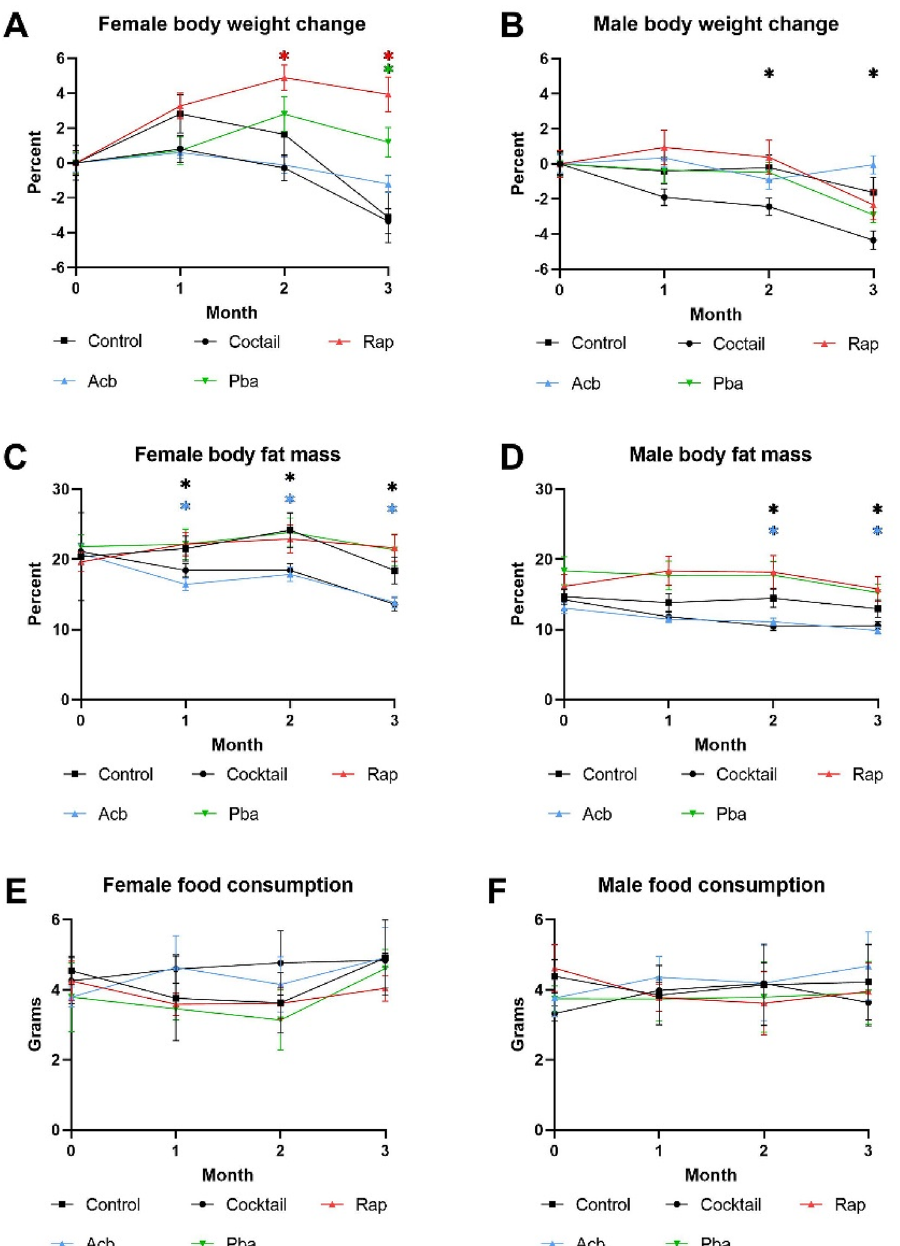
females, (F) food intake measured over 3 days each month for males. N = 12–14/cohort. *p ≤ 0.05, ANOVA with Tukey’s post-hoc comparison and two-tailed, unpaired Student’s